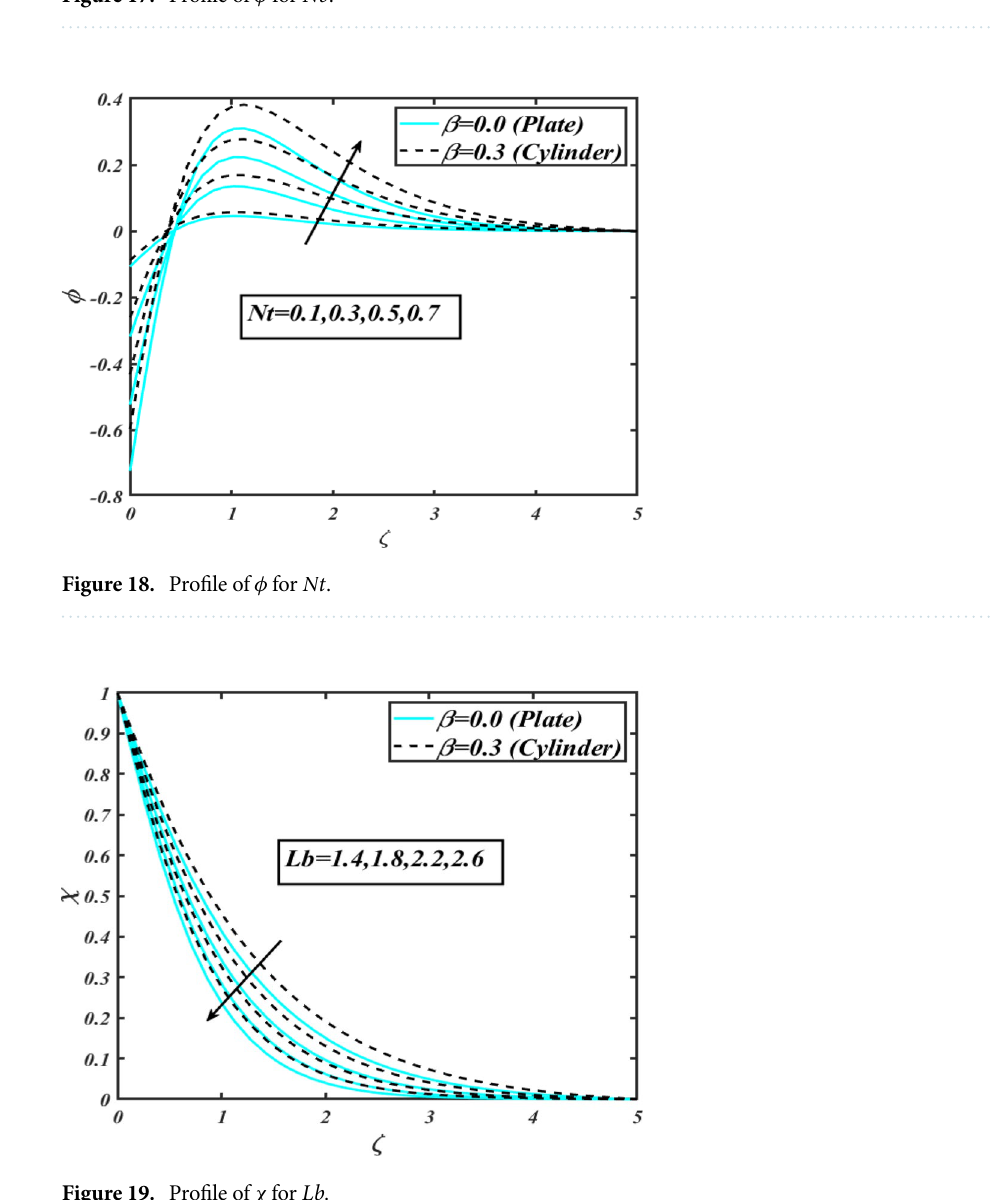
Figure 19. Profile of χ for Lb